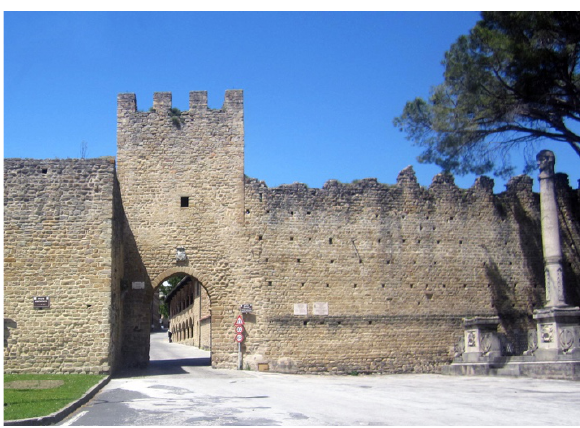
Figure 1. Porta Picena and adjacent curtain walls (ante 2016, ©